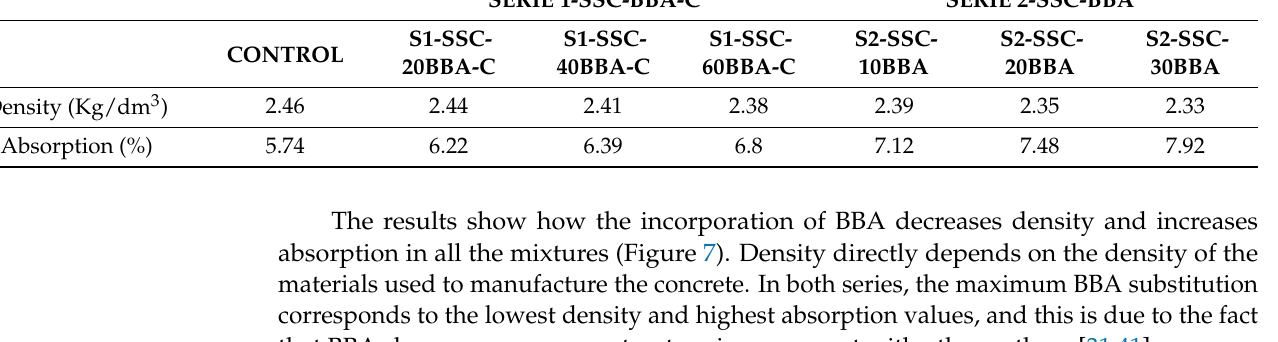
Table 7. Density and absorption of hardened concrete.